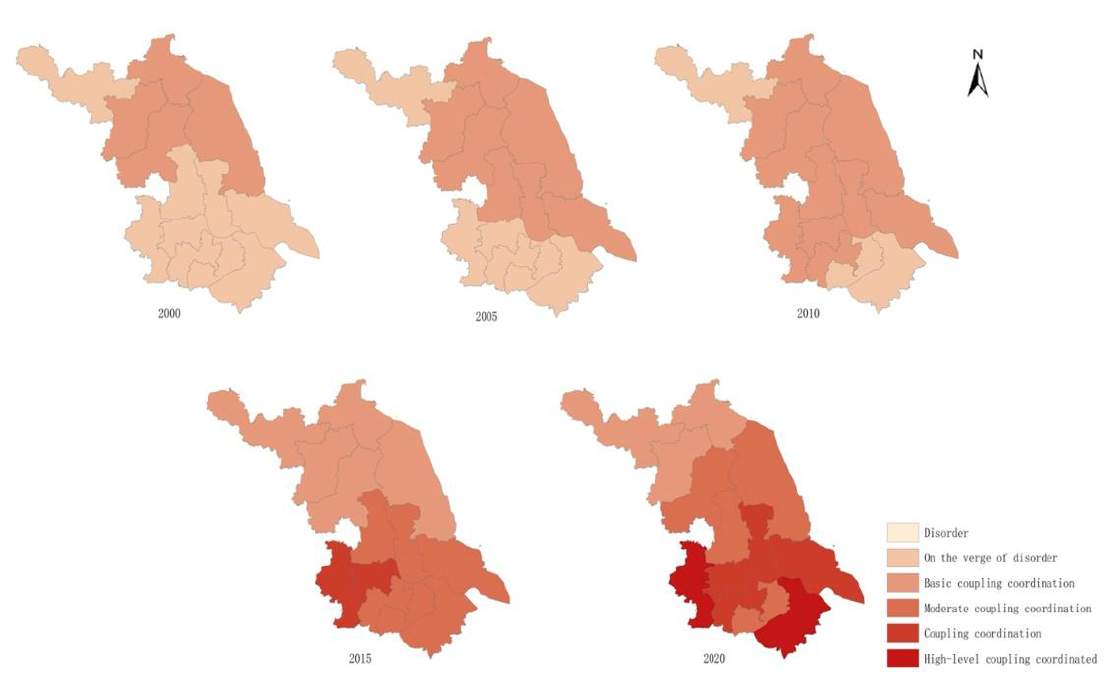
Figure 5. Spatial and temporal evolution of the degree of coordinated development of PRE systems in the cities of Jiangsu.